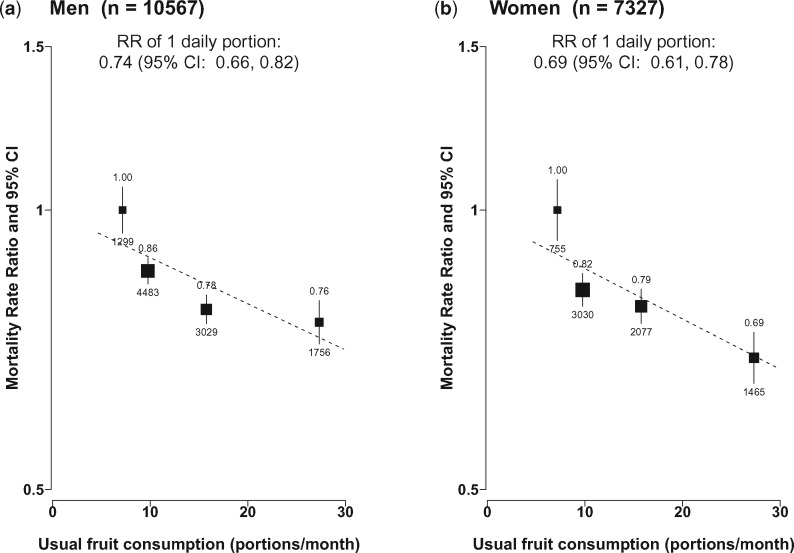
Sex-specific RRs for all-cause mortality by levels of fresh fruit consumption. Analyses were stratified by age-at-risk and study area and adjusted for education, income, alcohol consumption status, smoking, physical activity, intakes of dairy products, meat and preserved vegetables, survey season and BMI. Black boxes represent the point estimates of RRs, with the size inversely proportional to the variance of the log RRs, and the vertical lines represent the 95% confidence intervals (CIs). Values above the vertical lines are RR point estimates and values below them are numbers of deaths.